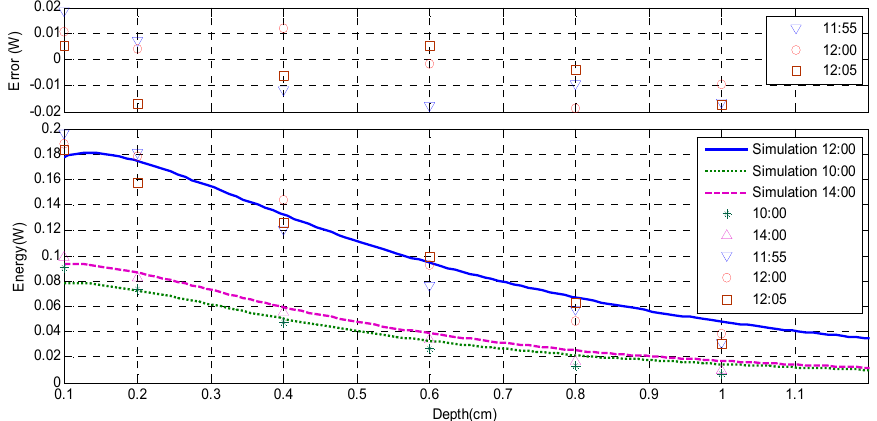
Figure 10. The physical measurement results and the corresponding simulation results of the recharging implantable biosensors based on solar radiation.